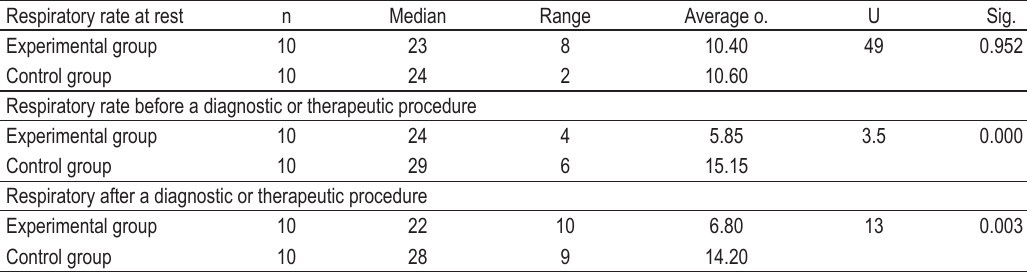
TABLE 3. Respiratory rate (Mann‑Whitney U) Respiratory rate at rest n Median Range Average